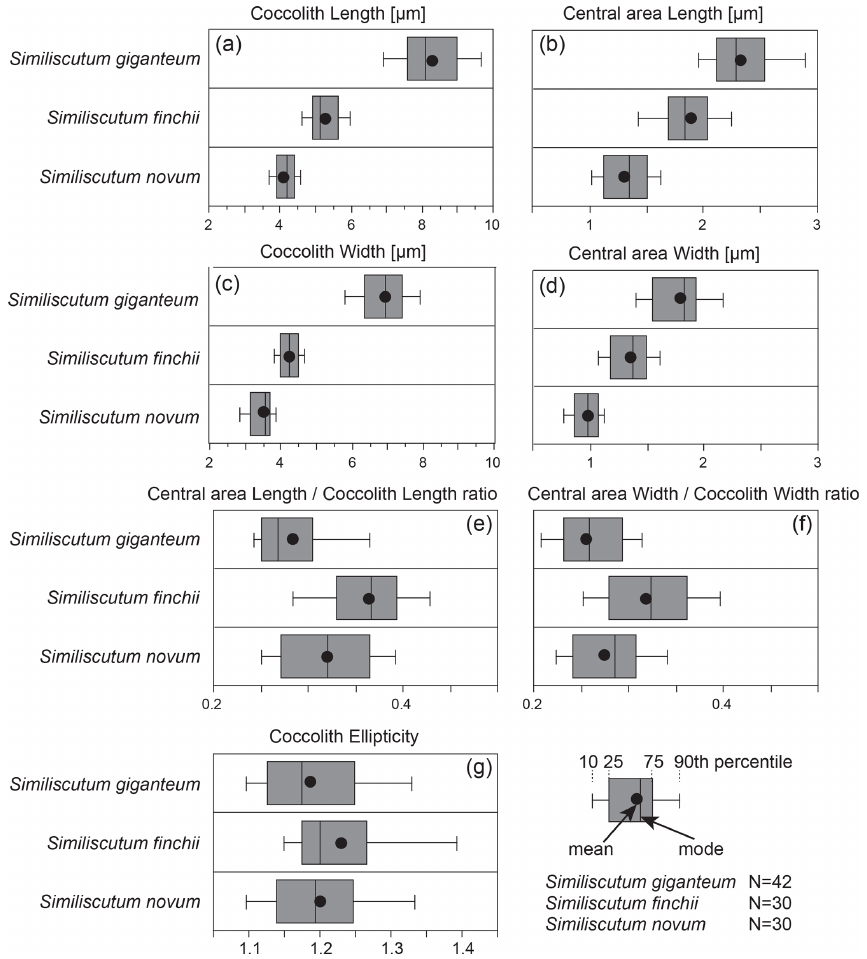
Figure 2. Frequency distribution of coccolith length (a) and width (c) and of central-area length (b) and width (d) of the ratios “central-area length over coccolith length” (e) and “central-area width over coccolith width” (f) , along with coccolith ellipticity (g) for the three analysed species. N is the number of measured